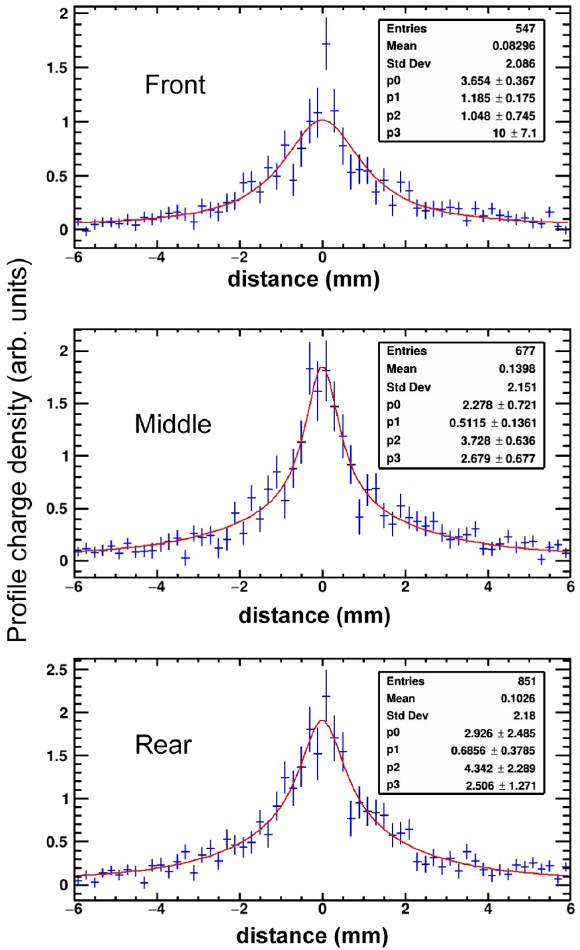
elements.FIG. charge (due to the Askaryan effect) in each of the three ACE elements, along with fitted parameters for the double Lorentzian profiles. In this case, the “ bins ” are combined totals from two adjacent binned slices through the center, a 2D histogram of the charge passing through each 0.2-mm squared